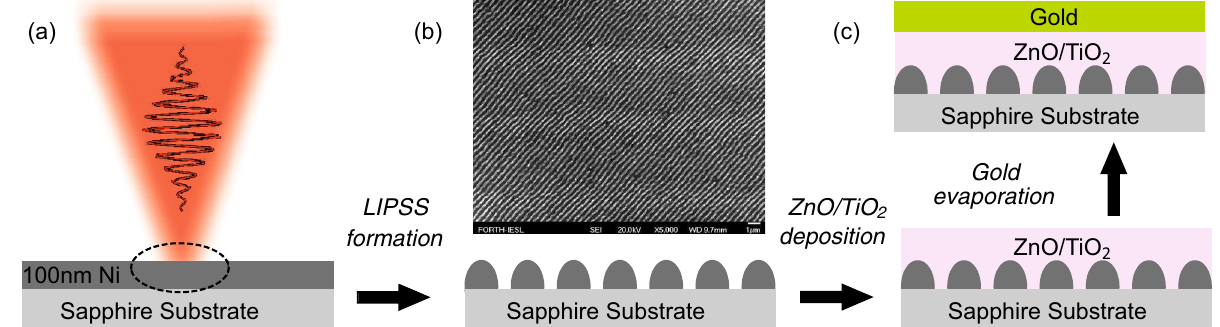
Figure 1. Schematic of the fabrication process employed for the realization of the gap plasmon metasurfaces. ( a ) LIPSS formation on a Ni thin film deposited on sapphire via irradiation with linearly polarized ultrashort laser pulses. ( b ) Schematic and top view SEM image of the LIPSS formed. ( c ) ZnO and TiO 2 deposition followed by gold evaporation which results in the metal-insulator-periodically corrugated metal type